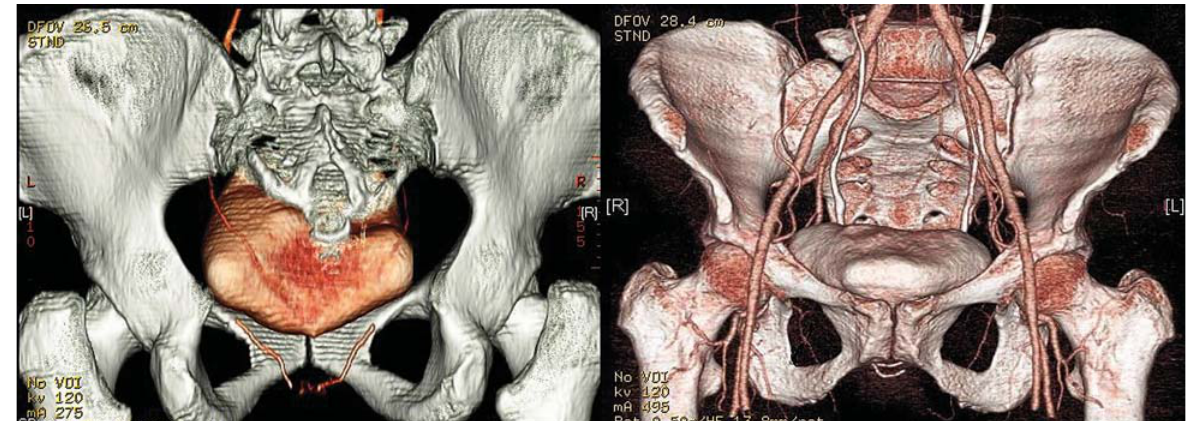
Figure 2 – Position of the Ophira ® mini-sling and its distance from the obturator